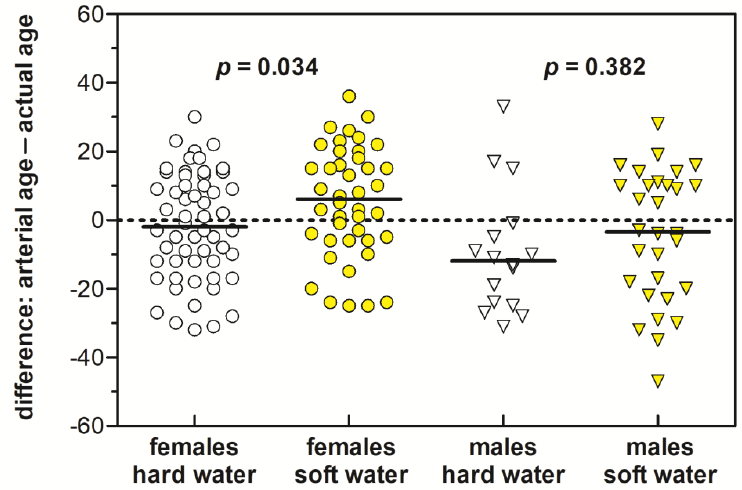
Figure 4. Scatter plot showing aortic pulse wave velocity (PWVao) values and arterial age of residents living in areas with different contents of Ca and Mg in drinking water. Horizontal continuous lines are the median values. White and yellow circles represent the individual PWVao values of the residents from hard and soft drinking water areas, respectively, while the white and yellow inverted triangles are the calculated arterial ages of the residents from hard and soft drinking water areas, respectively.